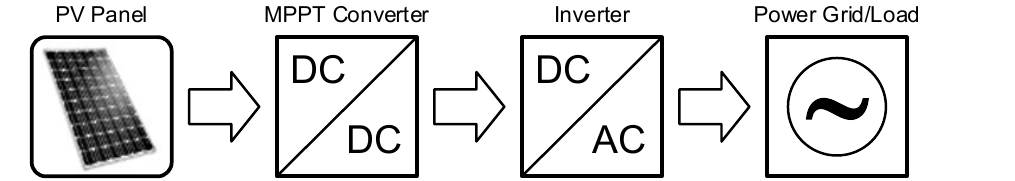
Figure 7. Block diagram of the energy conversion system.